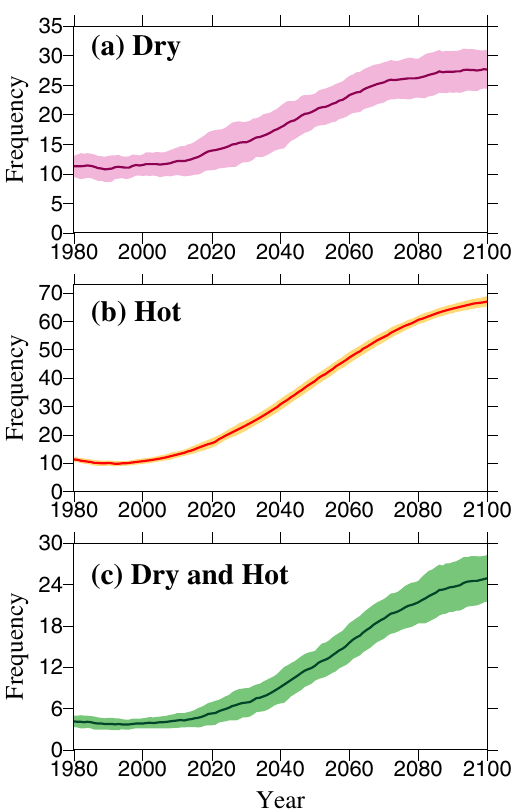
Fig. 3 Projected changes in the frequency (per year) of extreme dry, hot, and dry and hot pentads from CESM-LENS ensemble during 1951 – 2100. a 30-year moving mean frequency (per year) of extreme dry soil moisture pentads, b 30-year moving mean frequency (per year) of extreme hot pentads, and c 30-year moving mean frequency (per year) extreme dry and hot pentads. Extreme dry and hot pentads were estimated based on the standardized departure more than one standard deviation from the reference period of 1971 – 2000. Shaded area shows uncertainty due to internal climate variability in 40 CESM-LENS ensemble members. (Fig. 3a). More importantly, the frequency of extreme hot pentads is projected to increase by a factor of six by the end of the 21st century based on CESM-LENS simulations under the RCP 8.5 (Fig. 3b). The signi fi cant increase in extreme dry and extreme hot pentads is likely to result in a four-times rise in concurrent extreme warm and dry pentads from the current level under the future